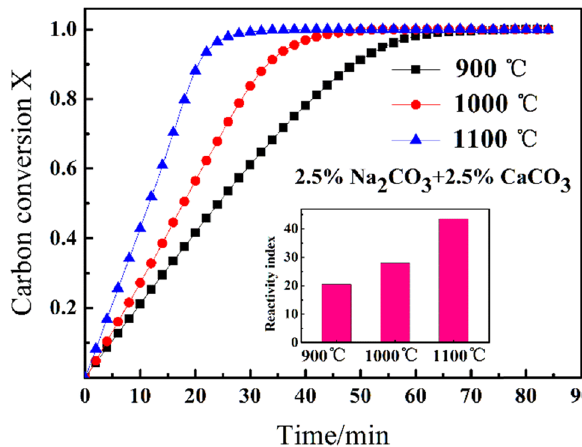
Figure 8: E ff ect of gasi fi cation temperature on the reactivity index and carbon conversion rate of ZJX char with composite fl ux agent